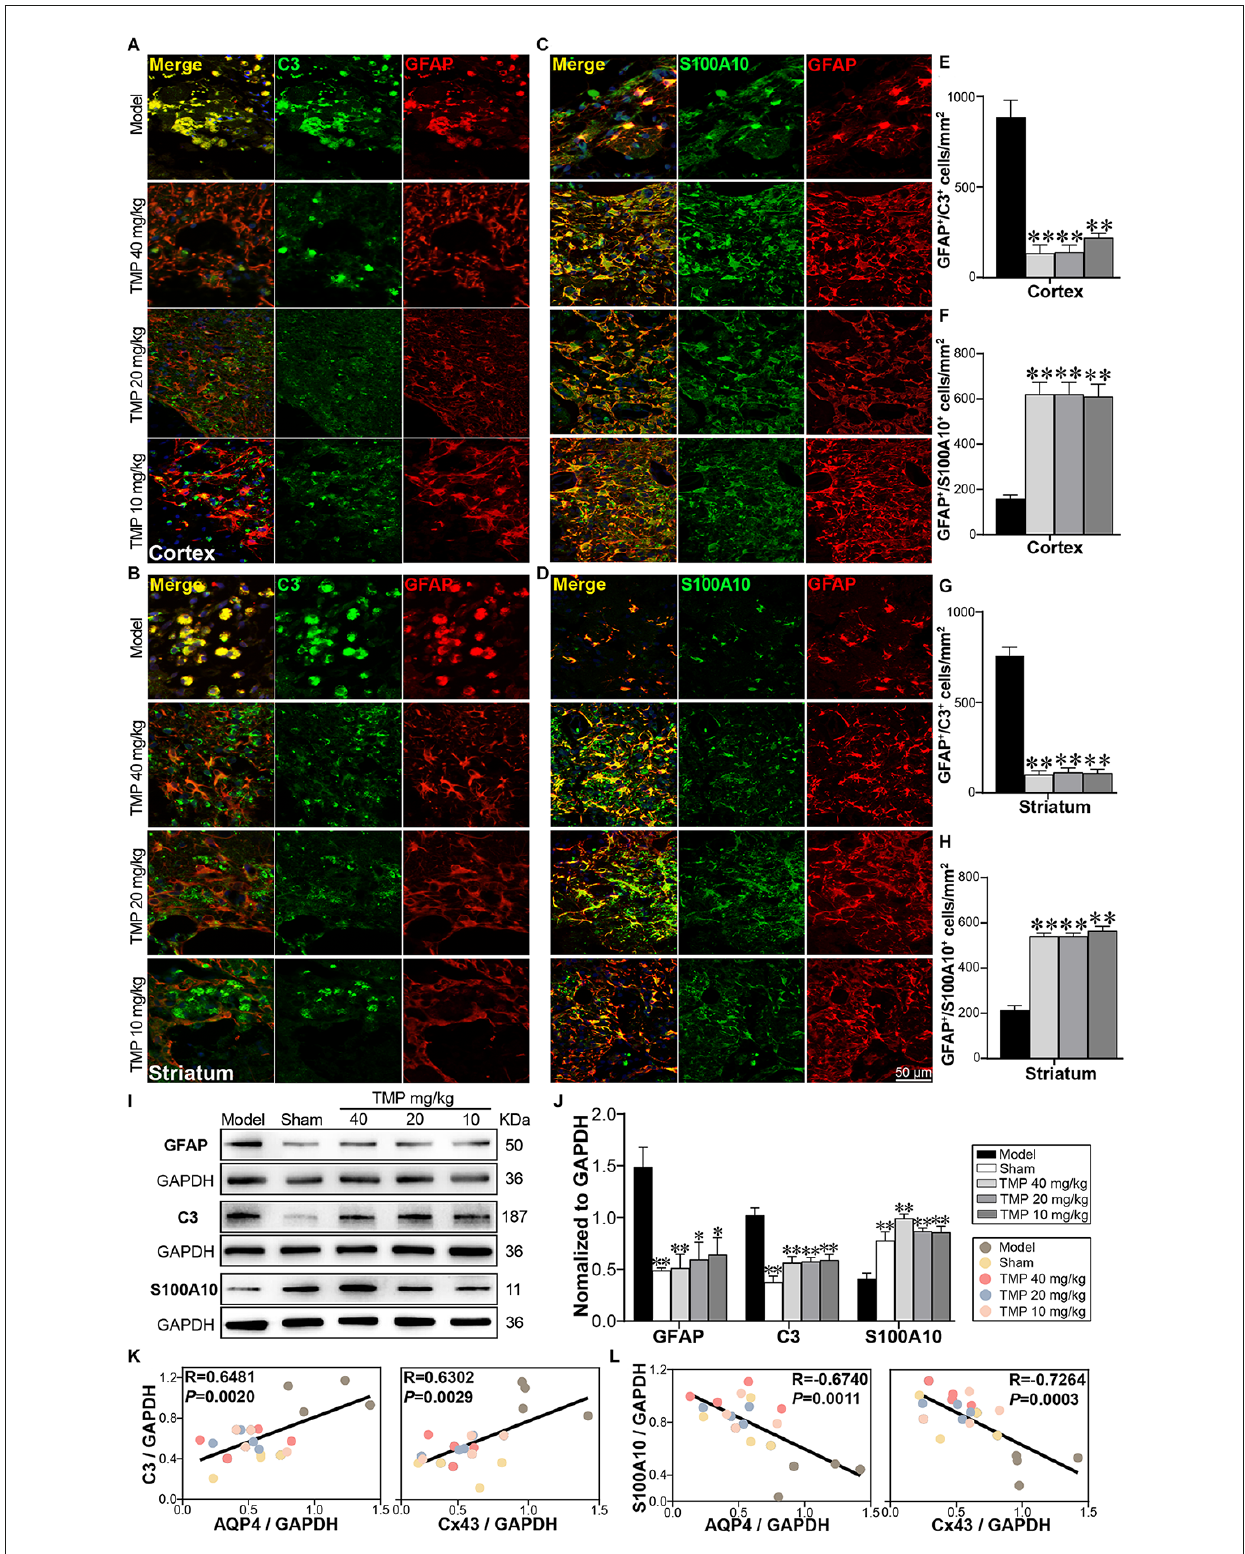
FIGURE7 TMP regulated A1/A2 astrocytic reactivity of MCAO rats. Immunofluorescence images showed co-localization of (A,B) GFAP (red) and C3 (green) and (C,D) GFAP (red) and S100A10 (green) in the periinfarct cortex and striatum ( n = 4). Merge (yellow) indicated GFAP/C3 or GFAP/S100A10 co-labeling cells. DAPI (blue) in merge pictures indicated cell nuclei. (E–H) Quantification of GFAP + /C3 + cells and GFAP + /S100A10 + cells in the periinfarct cortex and striatum of Model and TMP groups. (I,J) Western blot analysis for GFAP, C3 and S100A10 in the periinfarct cortex ( n = 4). (K,L) Correlations of the relative expressions between astrocytic functional proteins (AQP4, Cx43) and reactive astrocytic markers (C3, S100A10) in the periinfarct cortex. ∗ P < 0.05, ∗∗ P < 0.01 vs. Model